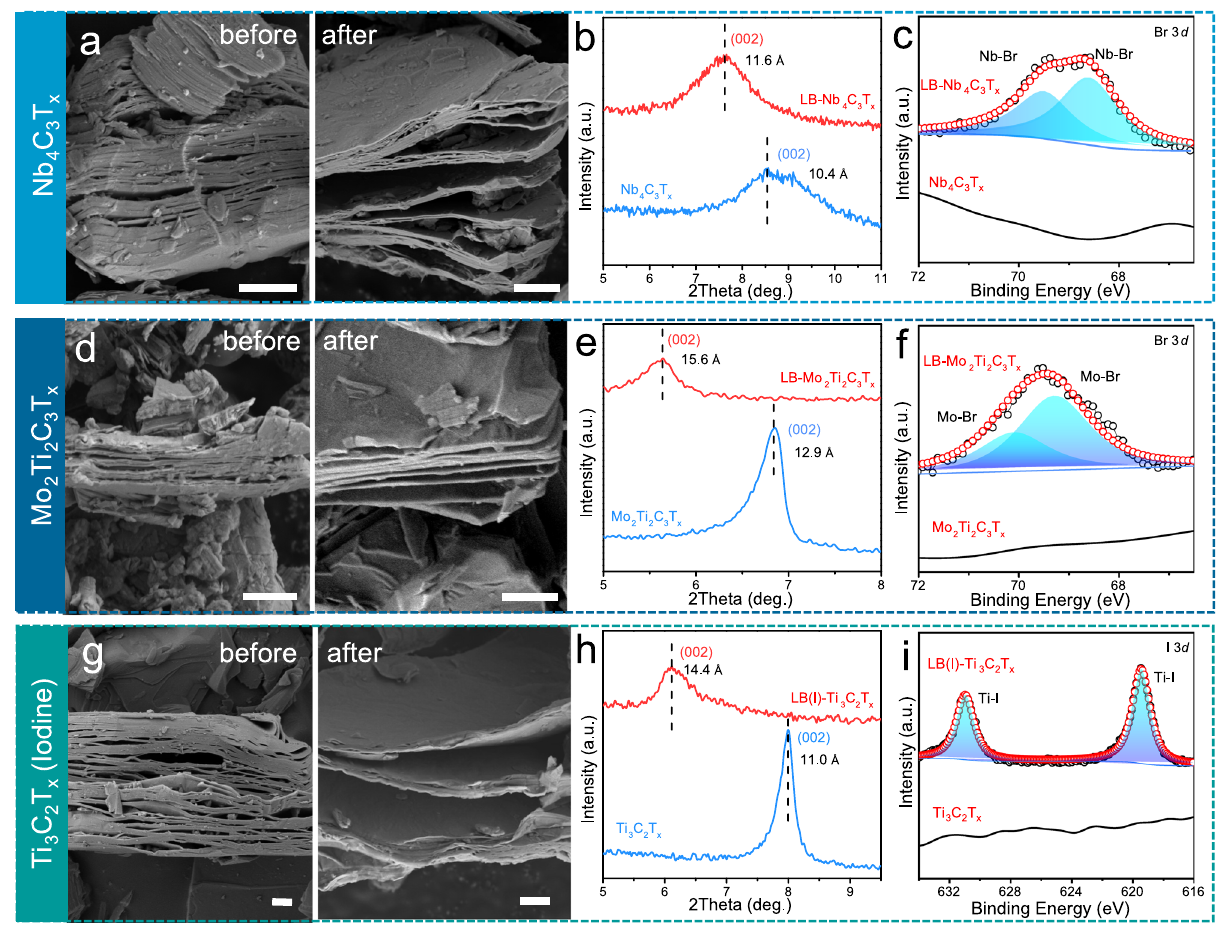
Fig. 3 | Universality of Lewis-basic halides treatment. a , d , g , SEM images of Nb 4 C 3 T x , Mo 2 Ti 2 C 3 T x , and Ti 3 C 2 T x -Iodine MXenes before and after Lewis-basic halidestreatment.Scalebar1 μ m. b , e , h ,XRDpatternsofNb 4 C 3 T x ,Mo 2 Ti 2 C 3 T x ,and